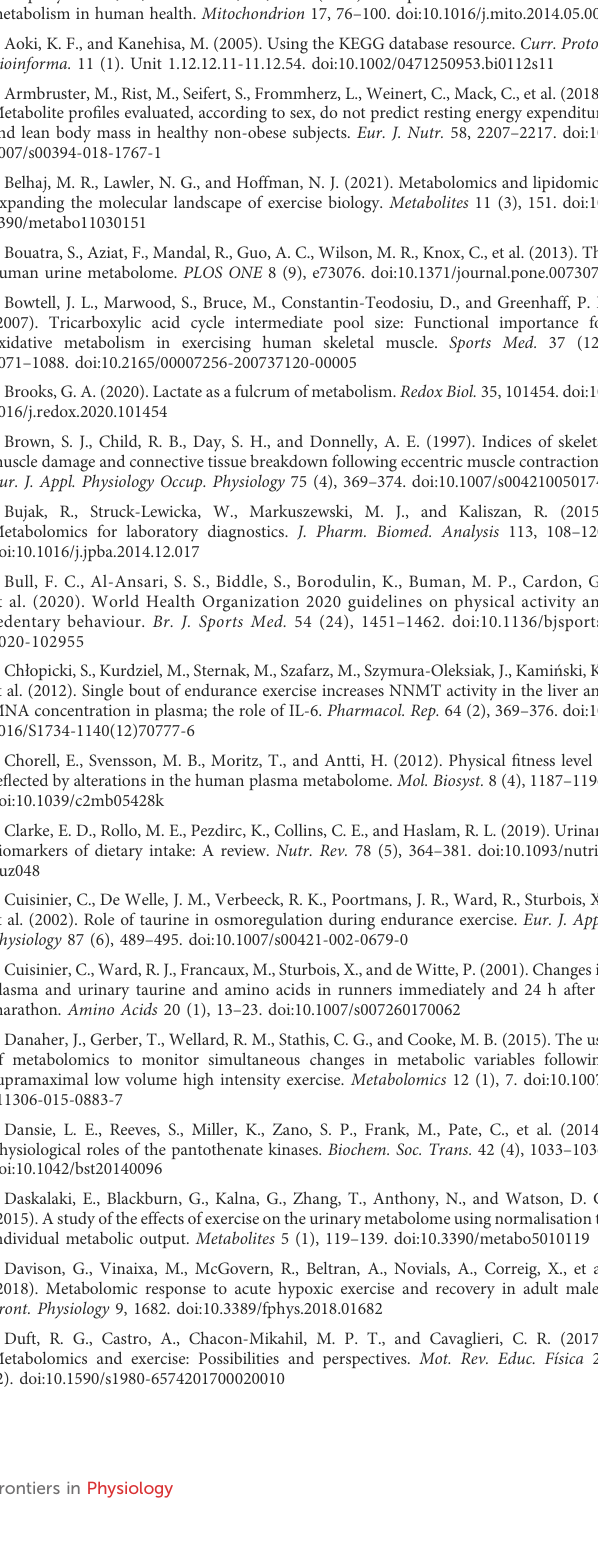
Boxplots of seven metabolites with relevant urinary concentration differences between trials and within either the CME or CVE trial, sorted by decreasing median FCs for U01/U00 ratio. On the y-axis, absolute concentrations in mmol/L per Osm/kg (targeted approaches) or signal intensities (untargeted GC×GC-MS) are displayed. *: relevant median FC > 2.0 or < 0.5 (GC×GC-MS